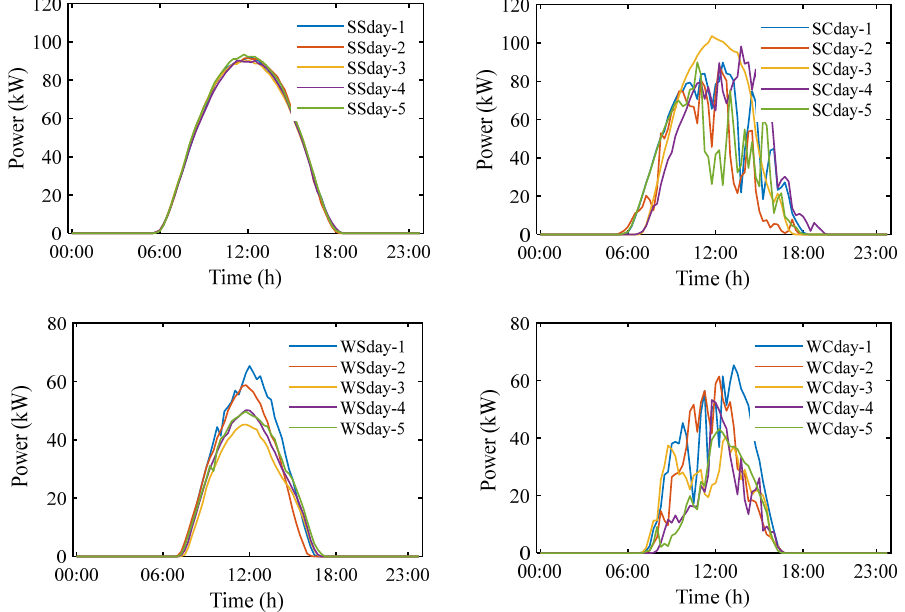
Figure 5. PV power generation prediction curves.